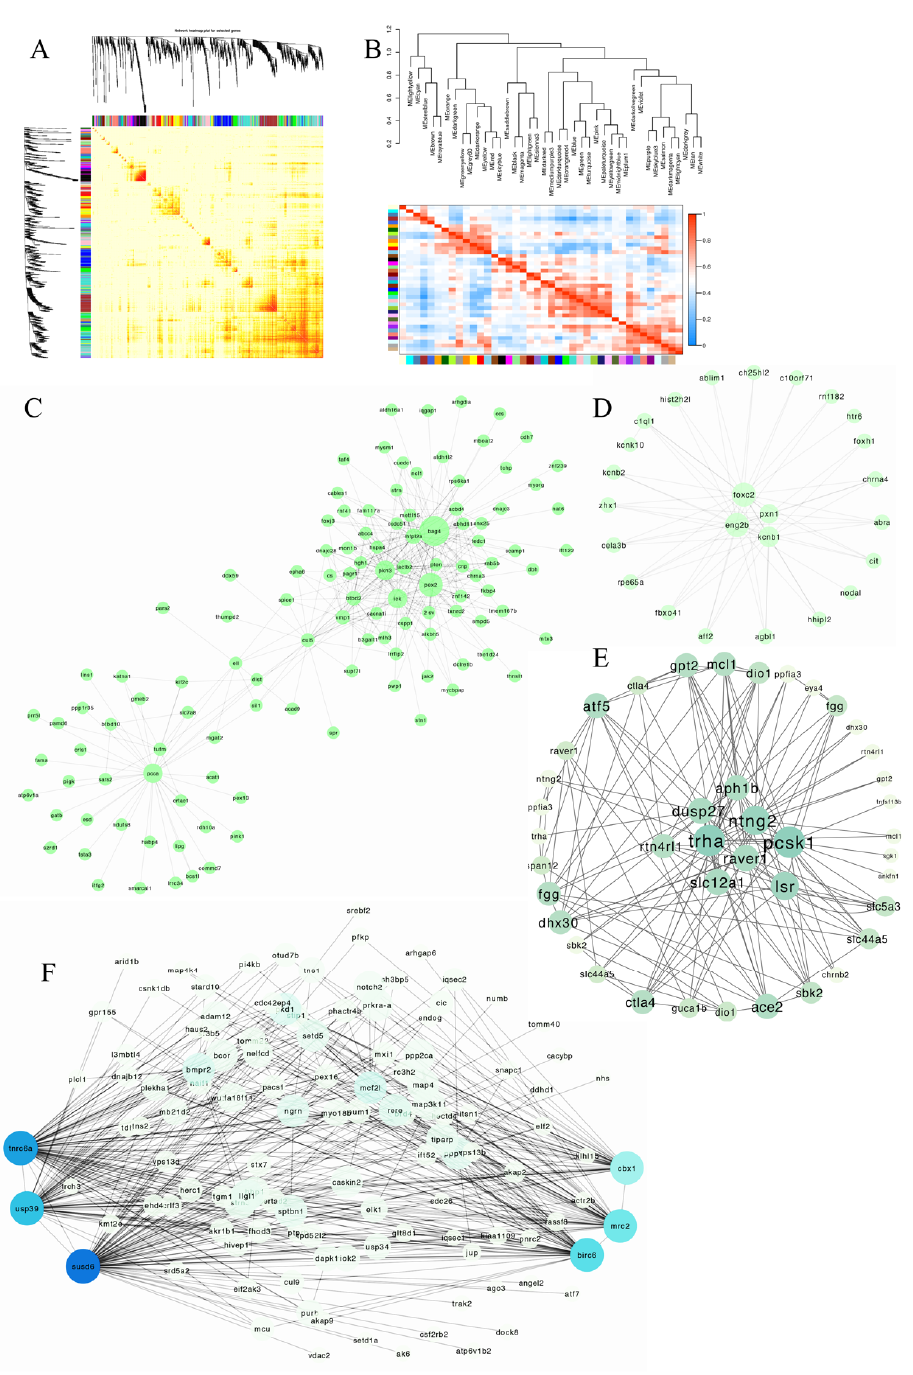
Figure 8. WGCNA analysis of RNA-seq and network visualization. ( A ): The heatmap of module- gene correlation. Each row and column represent a gene, and the darker the color of each point represents the stronger connectivity between the two genes. ( B ): The eigengene dendrogram of module membership. ( C ): Key genes related to copulation of the skyblue module. ( D ): The key